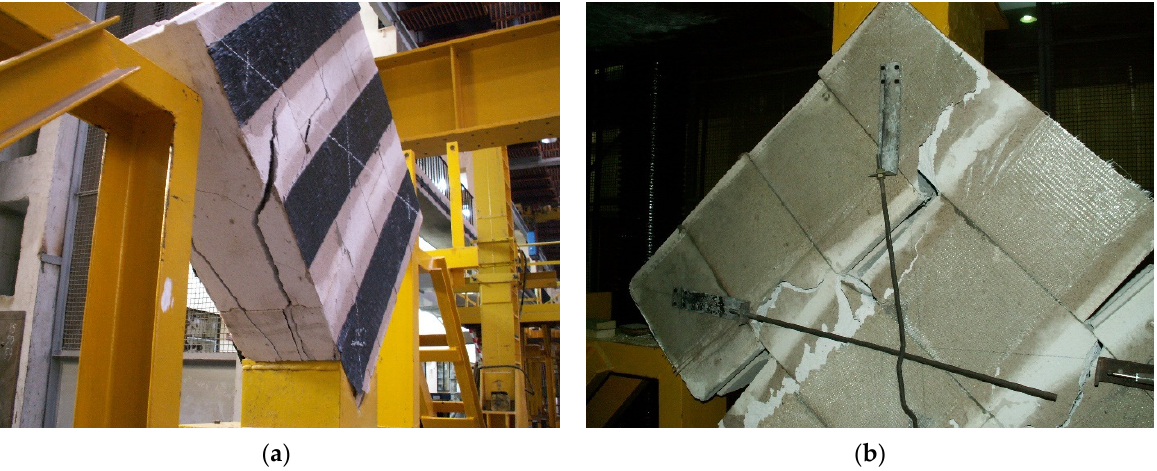
Figure 10. Failure pattern observed in walls strengthened in configuration ‘b’: ( a ) the elements with carbon strips; ( b ) the elements with glass strips.